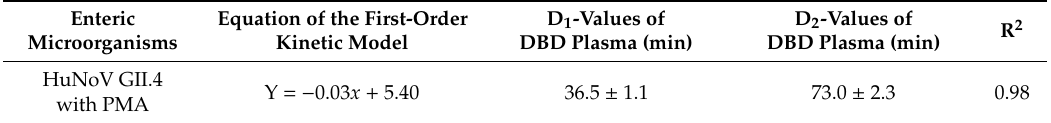
Table 2. E ff ect of DBD plasma treatment on the D R -values of HuNoV GII.4 with PMA reduction by first-order kinetics model in the oyster.